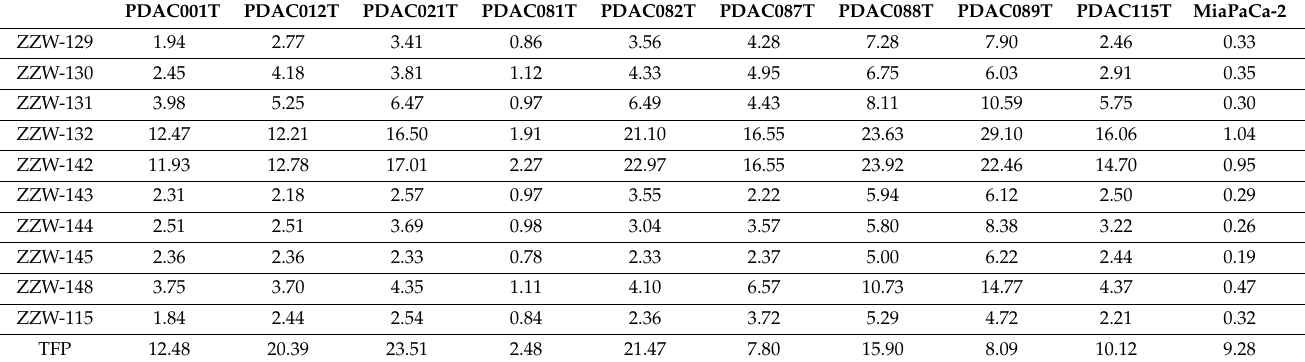
Table 2. IC 50 (in µ M) for the different assayed cell-lines with the ZZW-115-derived compounds.